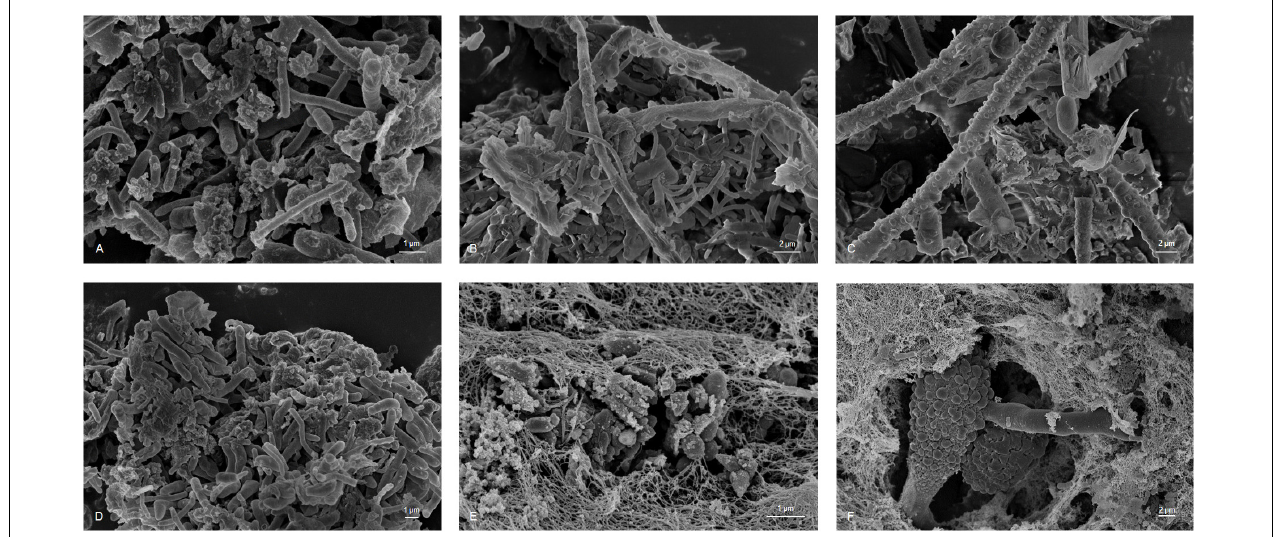
FIGURE 1 | Scanning Electron Microscopy microphotography of sampled material showing hypha and conidia of fungi species and bacteria integrated in an EPS matrix (A) sample 1, (B) sample 2, (C) sample 3, (D) sample 4, (E) sample 5, and (F) sample 6; scale bars of 1–2 µ m are indicated in the images (REM LEO 1525, 5.00